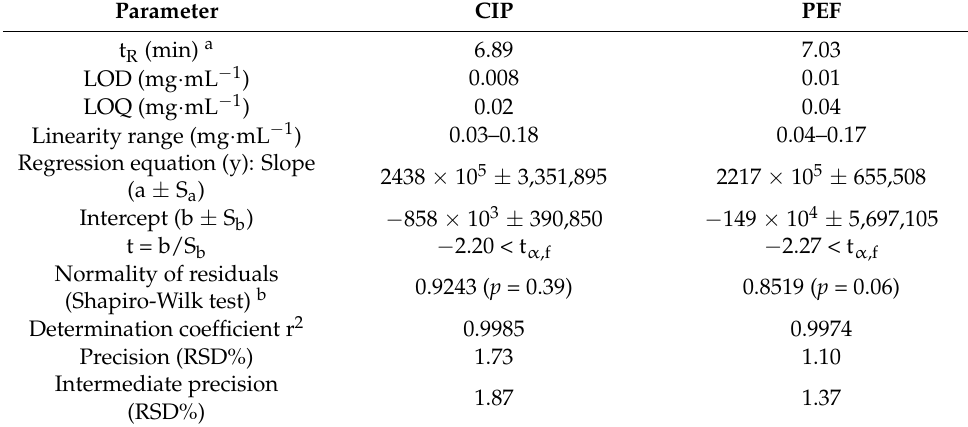
Table 2. Method validation